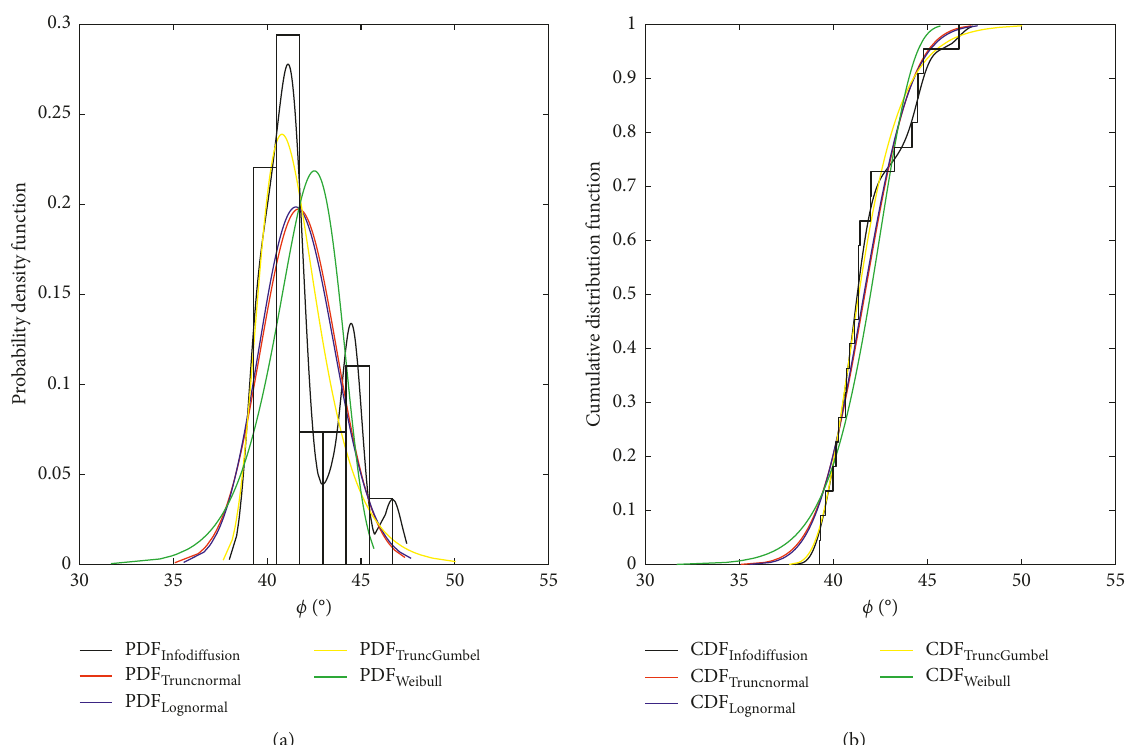
Figure 15: PDF and CDF plots of φ ′ reproduced by Gaussian copula coupling different